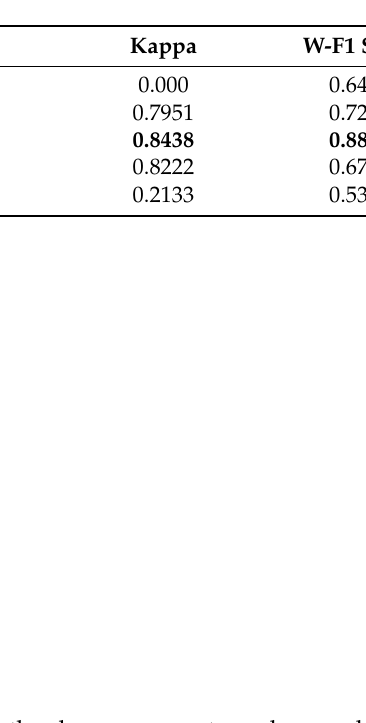
Figure 9. Selection of batch size.